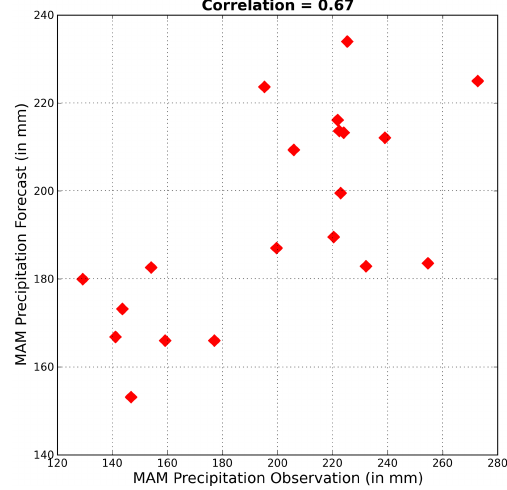
Figure 7. Comparison of ensemble median MAM precipitation forecasts and observations (CHIRPS) spatially aggregated over the focus